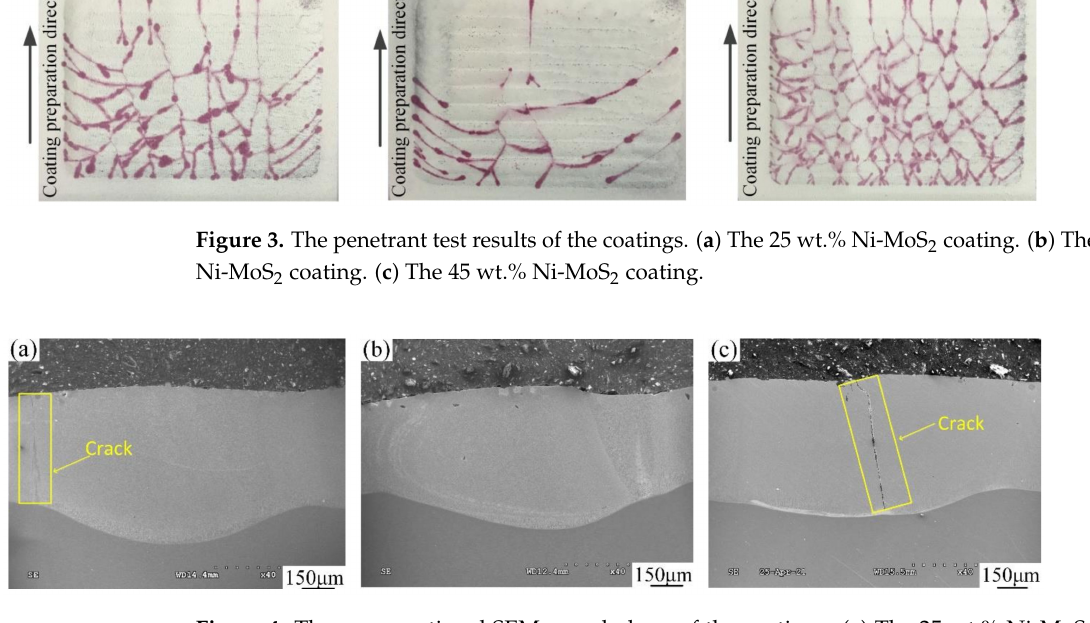
Figure 4. The cross-sectional SEM morphology of the coatings. ( a ) The 25 wt.% Ni-MoS 2 coating. ( b ) The 35 wt.% Ni-MoS 2 coating. ( c ) The 45 wt.% Ni-MoS 2 coating.